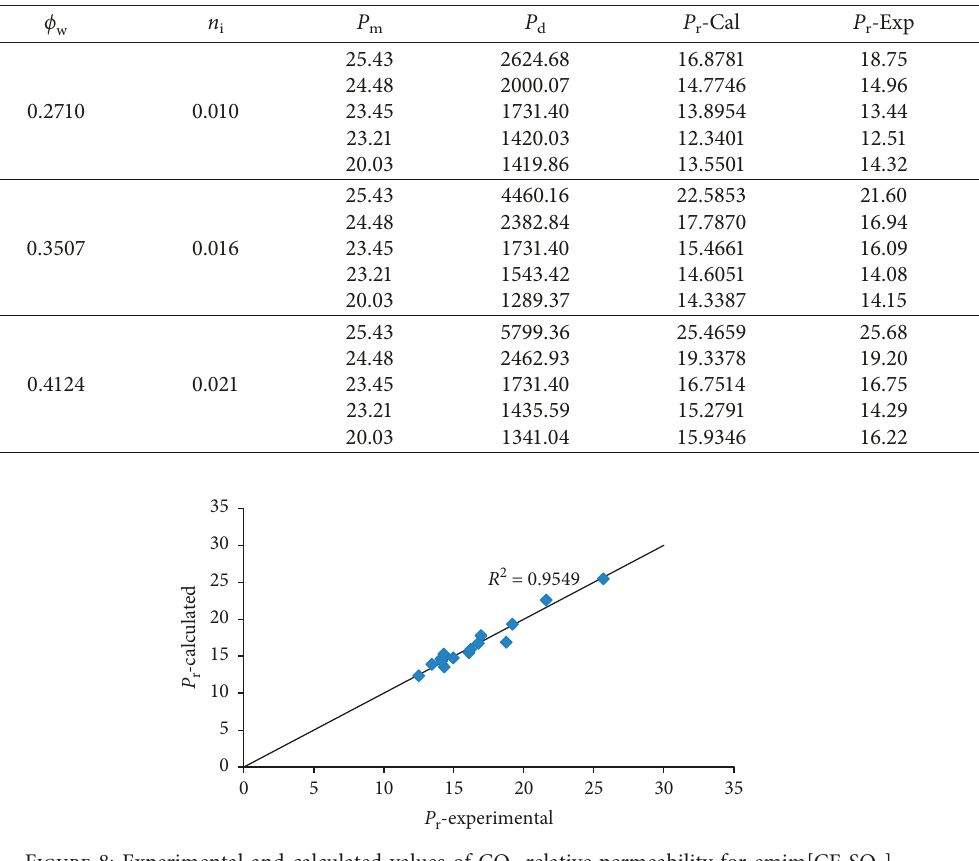
Figure 8: Experimental and calculated values of CO 2 relative permeability for emim[CF 3 SO 3 ]. Table 10: CO 2 permeability of three-component MMMs [17]. Membrane